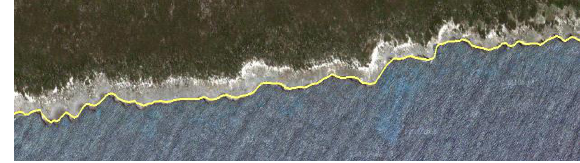
Figure 5. Result of the vector generated over an abrasive coast sector.